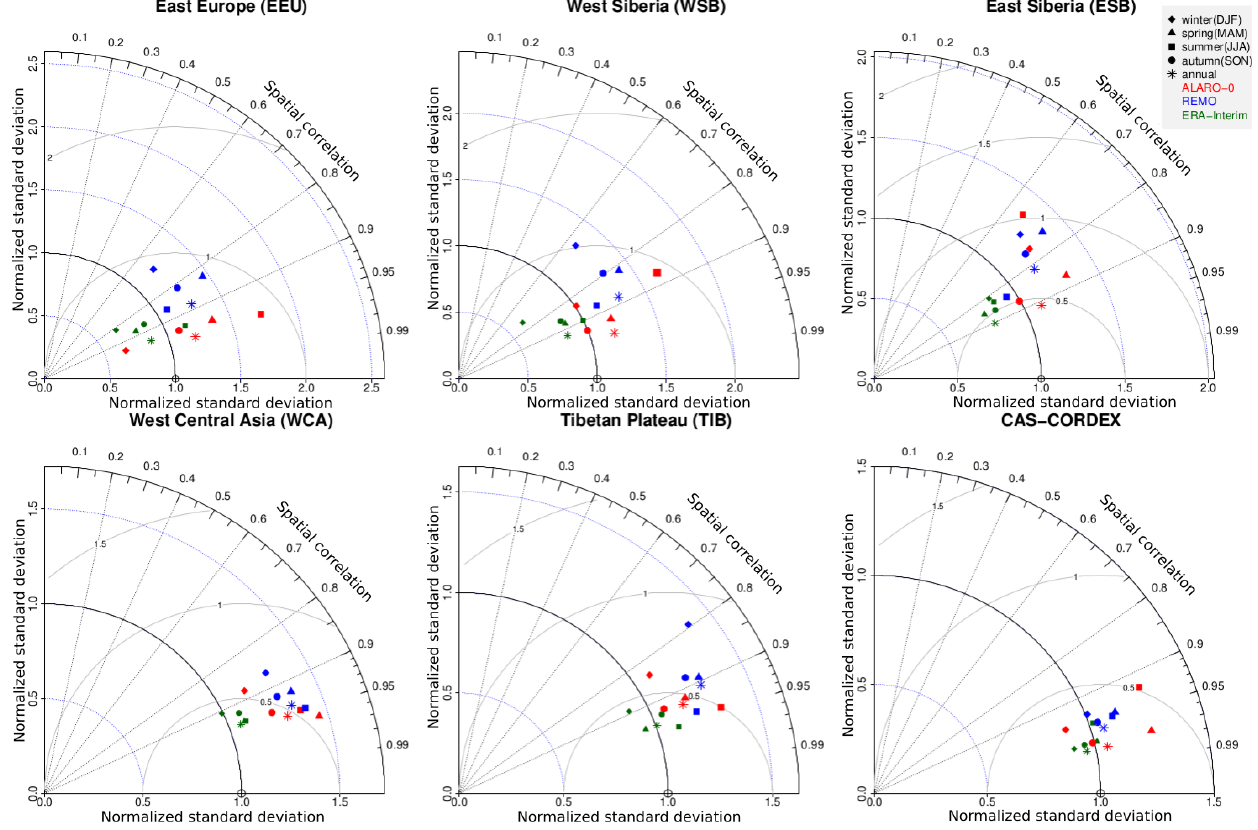
Figure 7. Normalized Taylor diagram showing the model spatial performance of the minimum temperature for seasonal and annual means for both RCMs (ALARO-0 and REMO) and ERA-Interim reanalysis with respect to CRU for the five subregions and the complete CAS- CORDEX